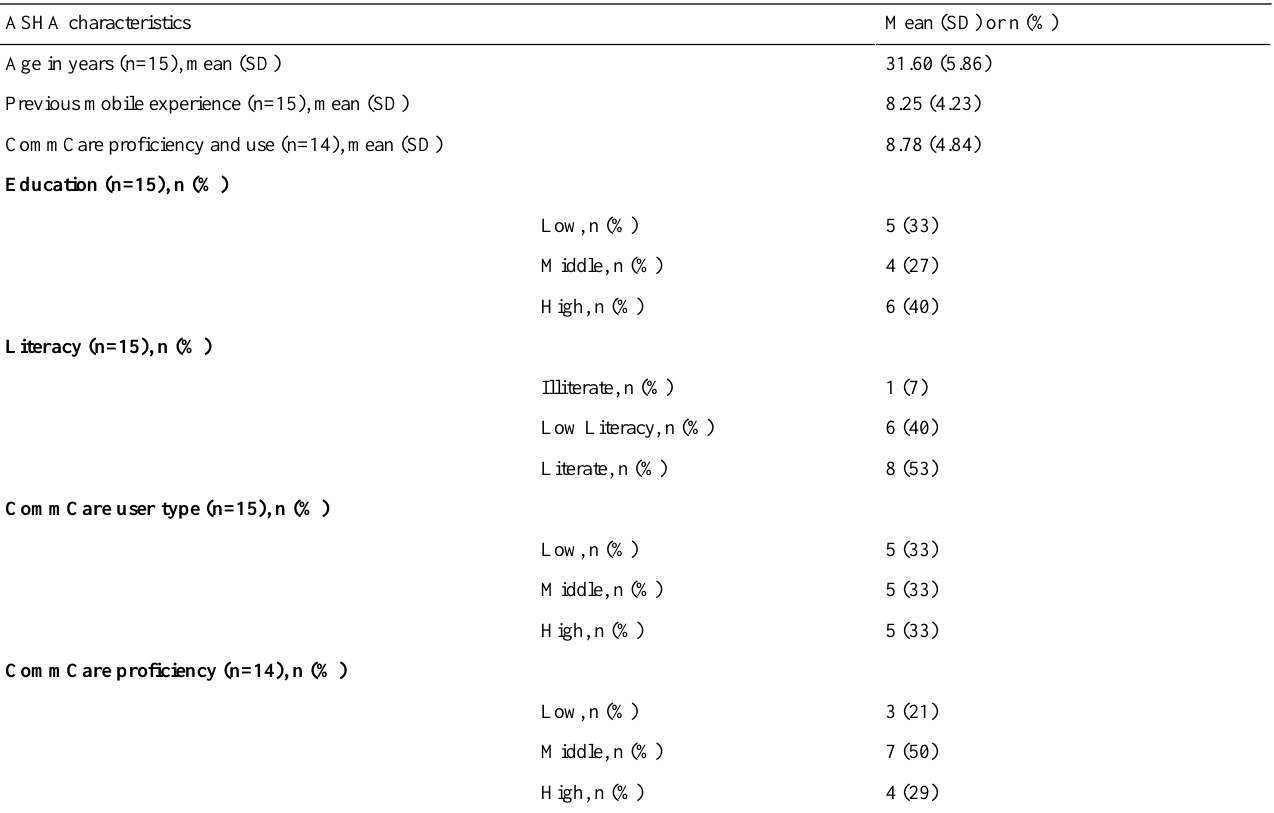
Table 3. Descriptive statistics of ASHA